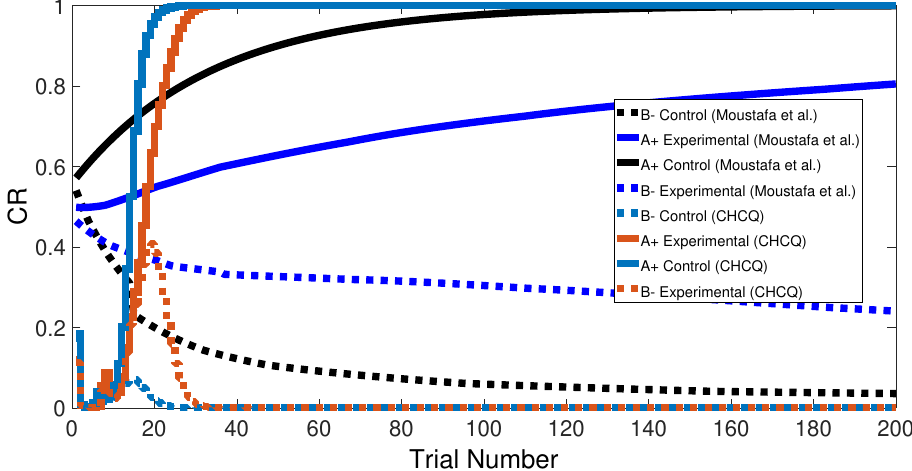
Figure 31. Only the last phase of compound preconditioning task for the intact